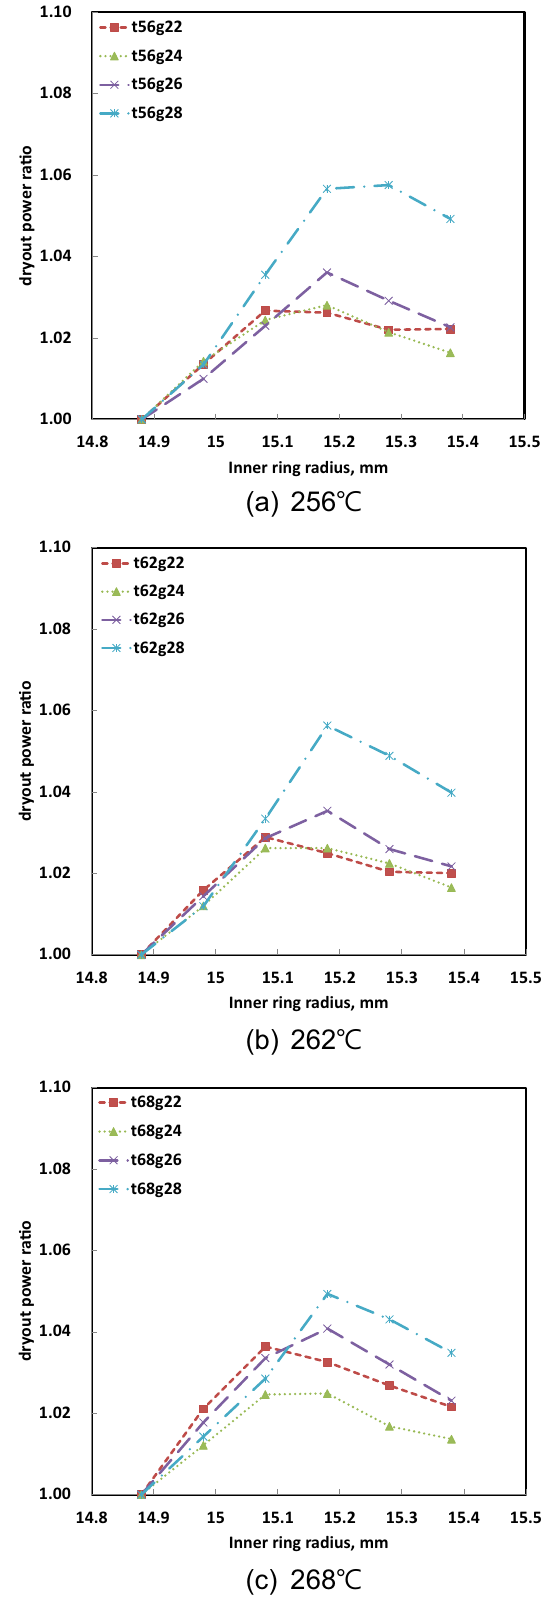
Fig. 9. Dryout power ratio of a 37A fuel bundle for 0% crept pressure